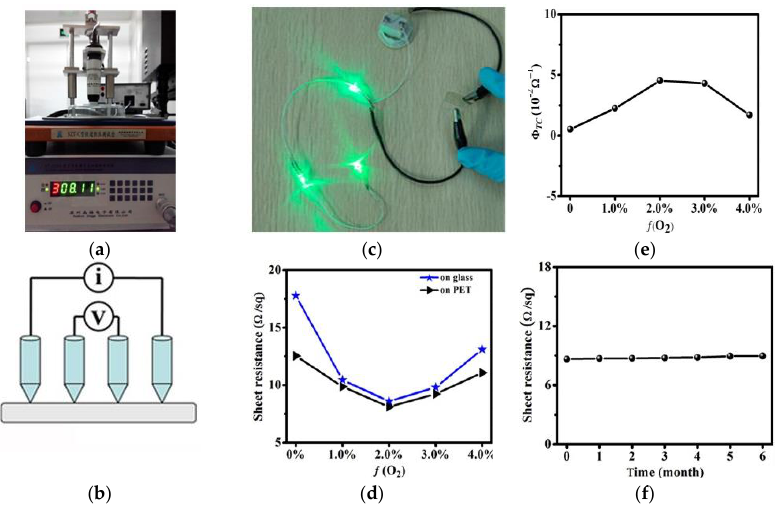
Figure 6. ( a ) Sheet resistance of the transparent electrodes (f(O 2 ) = 2.0%) measured using a four-point probe instrument; ( b ) the schematic pictures of four-point probe; ( c ) flexible transparent film (f(O 2 ) = 2.0%) in an electrical circuit powering three LEDs; ( d ) electrical properties of ZnO/Ag/ZnO multilayer films with different f(O 2 ) from 0% to 4.0%; ( e ) Φ TC of ZnO/Ag/ZnO multilayer films with different f(O 2 ) from 0% to 4.0%; and ( f ) sheet resistance changes of ZnO/Ag/ZnO (f(O 2 ) = 2.0%) under an air atmosphere at room temperature for six months.